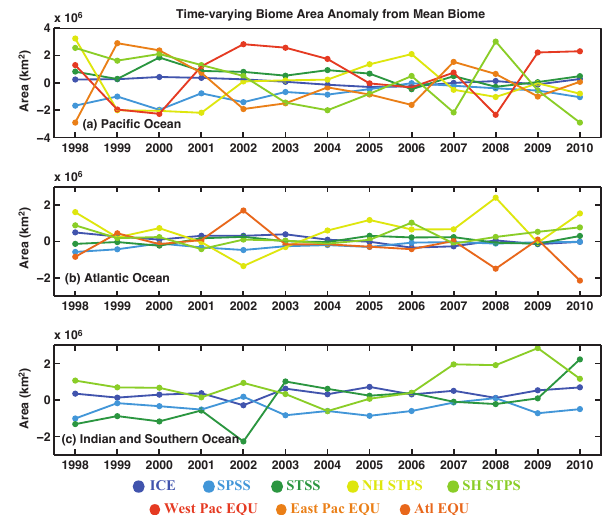
Figure 5. Biome area anomaly as the residual from the correspond- ing mean biome area for years 1998–2010 in (a) Pacific Ocean; (b) Atlantic Ocean; and (c) Southern and Indian oceans. Dark blue: ICE; cyan: SPSS; green: STSS; yellow: Northern Hemisphere STPS; orange: EQU; light green: Southern Hemisphere